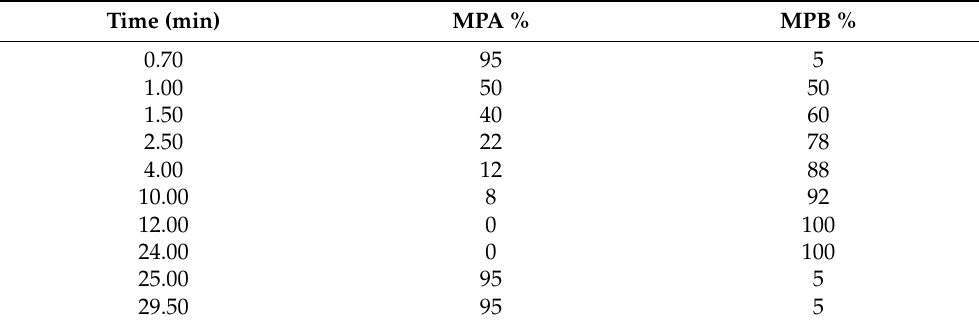
Table 1. The gradient elution